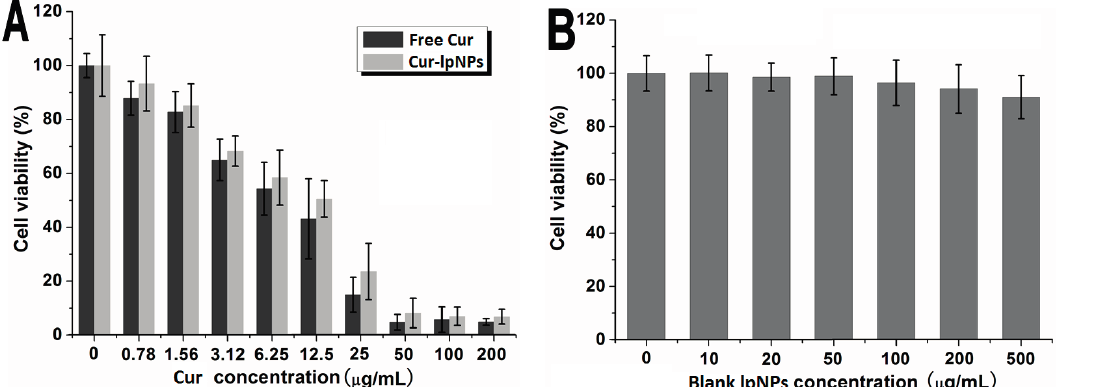
Figure 3. Cytotoxicity of Cur–lpNPs, free Cur and blank lpNPs. ( A ) Cytotoxicity evaluation of Cur–lpNPs and free Cur on B16 cells; ( B ) Cytotoxicity study of blank lpNPs on HEK293